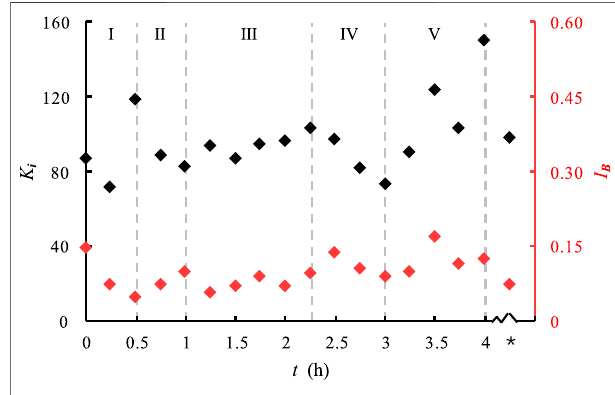
FIGURE 4 | The shear stress — displacement curve of samples under different thawing time. FIGURE 5 | The relationship of K i , I B with thawing